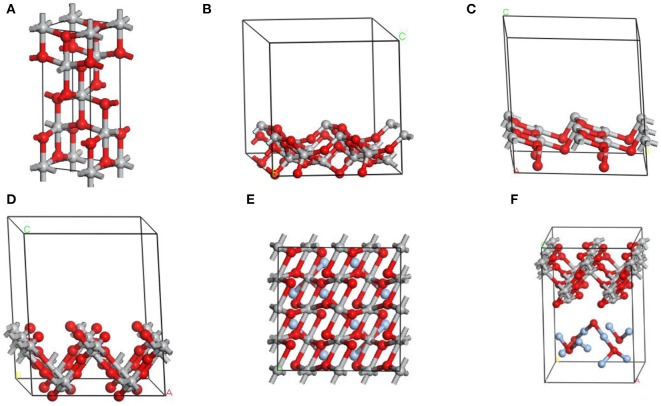
The image of (A) conventional cell of TiO2 in the anatase structure. Side view of crystal structures of different surface cells of TiO2 crystal used for surface energy calculation: (B) [101]; (C) [100]; (D) [001]. (E,F) Top and side views of the optimized geometric structures for Ag2O-TiO2 (001). Azury, red, and gray balls represent Ag, O, and Ti atoms, respectively.